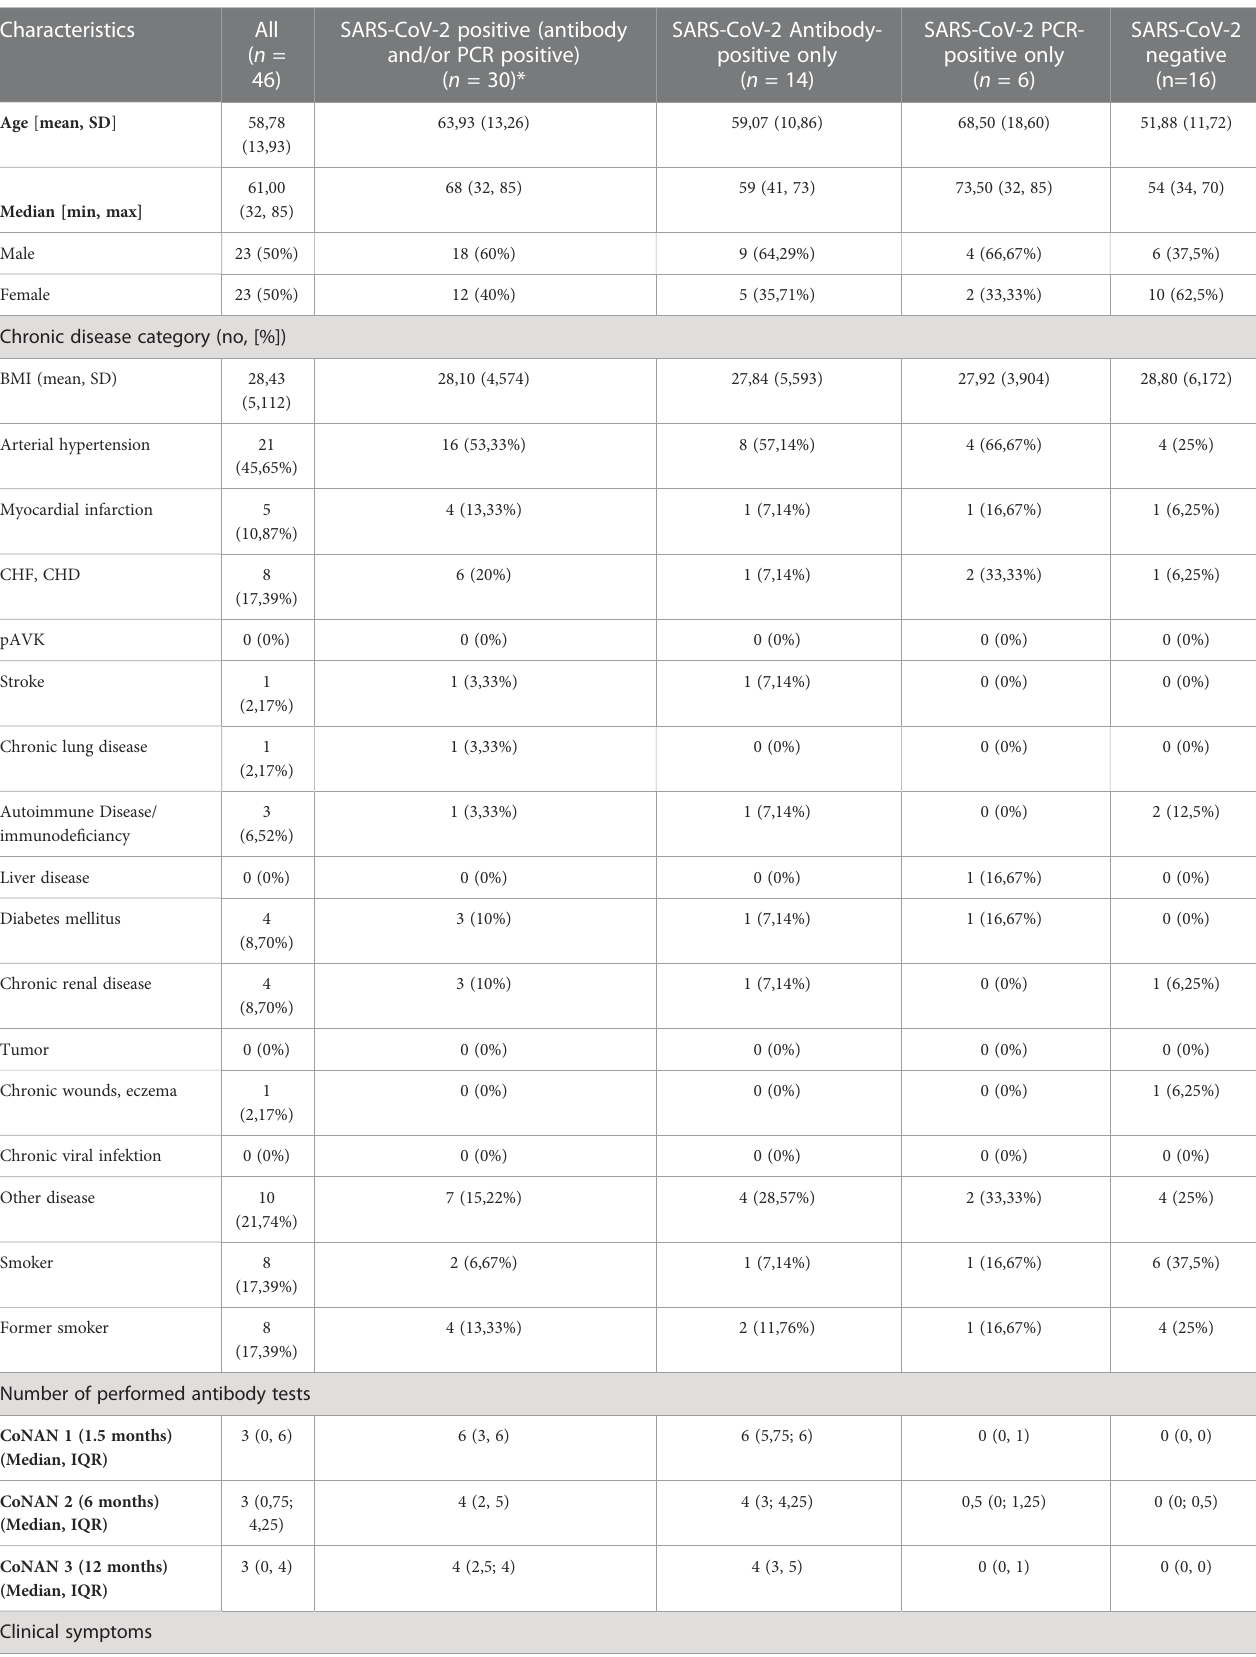
TABLE 2 Participants characteristics of the T H cell longitudinal cohorts.